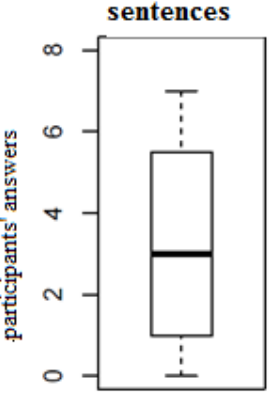
Figure 2 . Boxplot for the participants